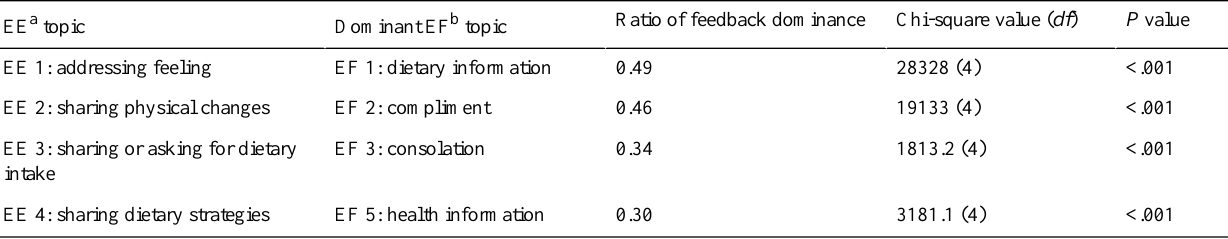
Table 5. Dominant feedback topic on each emotional eating–related behavior